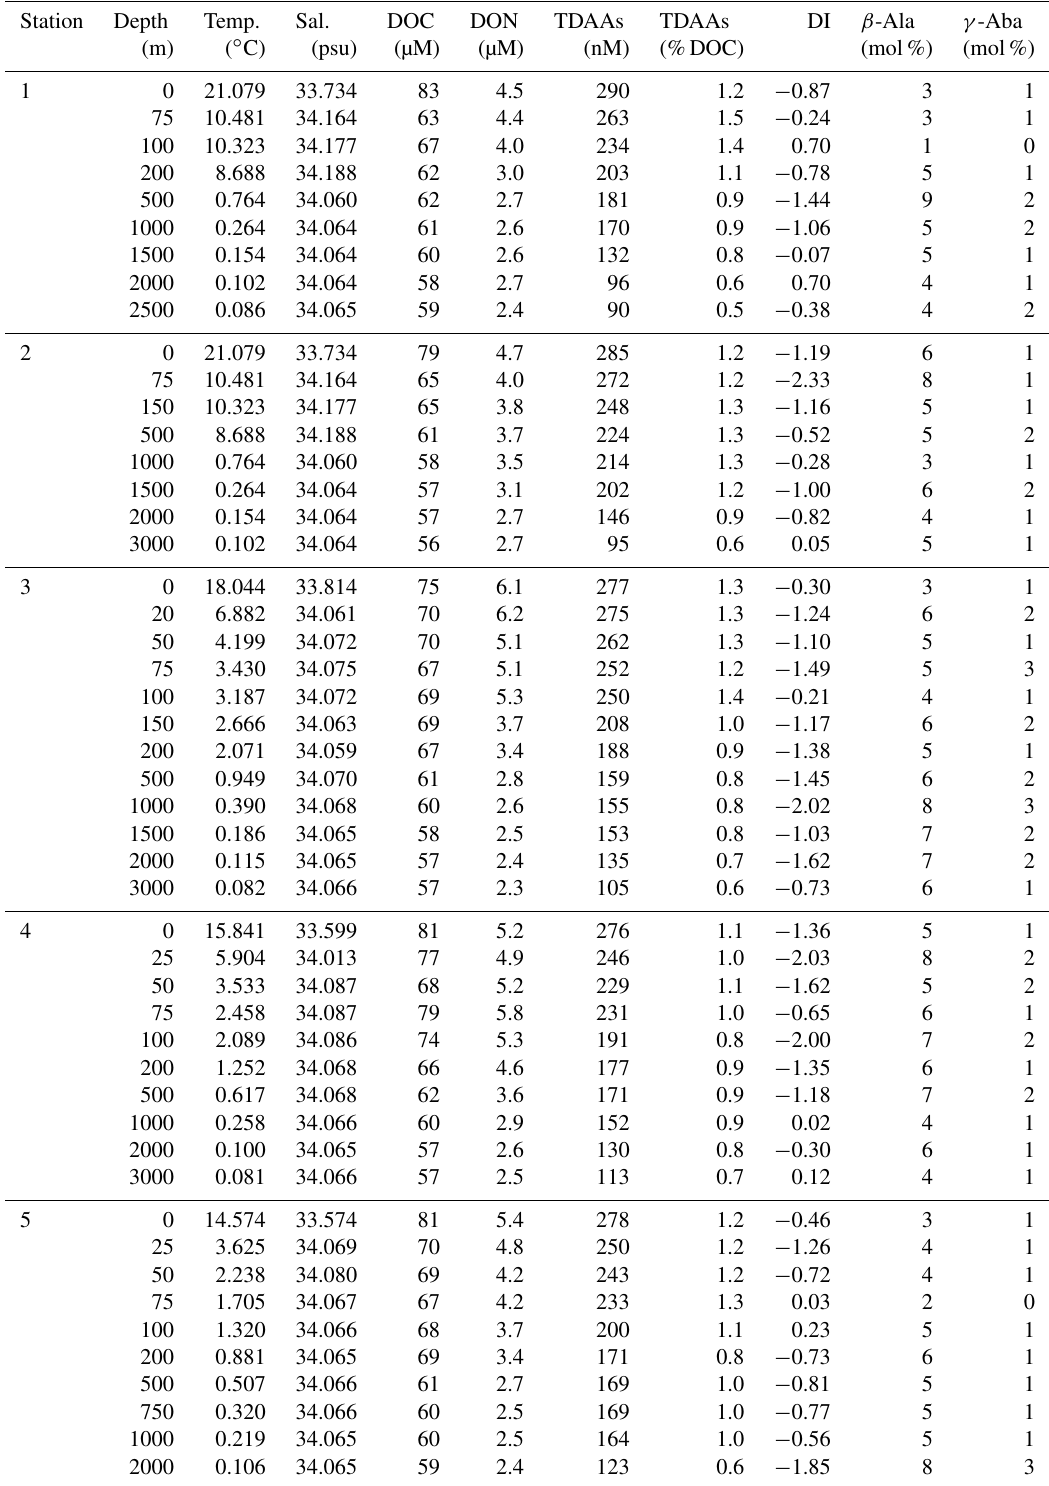
Table 1. Physicochemical characteristics in the East/Japan Sea.